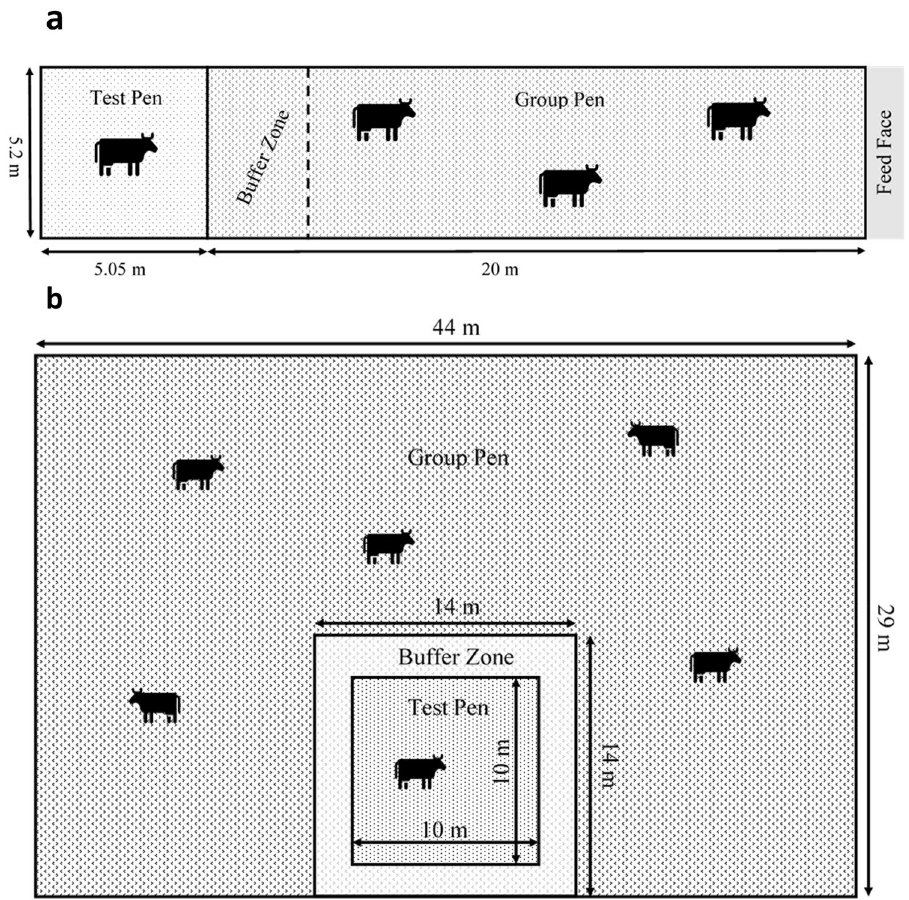
Figure 2. Diagrams of group and test pen design in the UK indoor housed study ( a ) and in the NZ outdoor pasture study (NZ) ( b ). During recordings, the test cow was moved into the test pen, when not recording, the cow was moved back into to the group